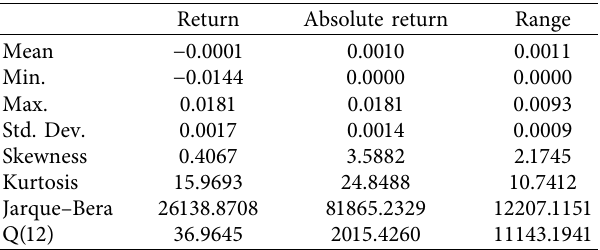
Figure 1: USD/CNY daily returns and ranges for the period January 2, 2006, to December 31, 2020. Table 1: Descriptive statistics for the USD/CNY daily returns and ranges for the period January 2, 2006, to December 31, 2020.